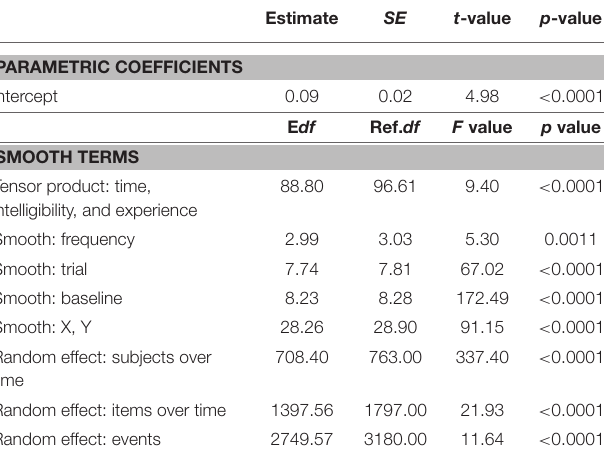
TABLE 1 | Generalized additive mixed model reporting parametric coefficient and Estimated degrees of Freedom (E df ), Reference Degrees of Freedom (Ref. df ), F , and p -Values for the Tensor Product, Smooth Terms, and Random Effects for the Final